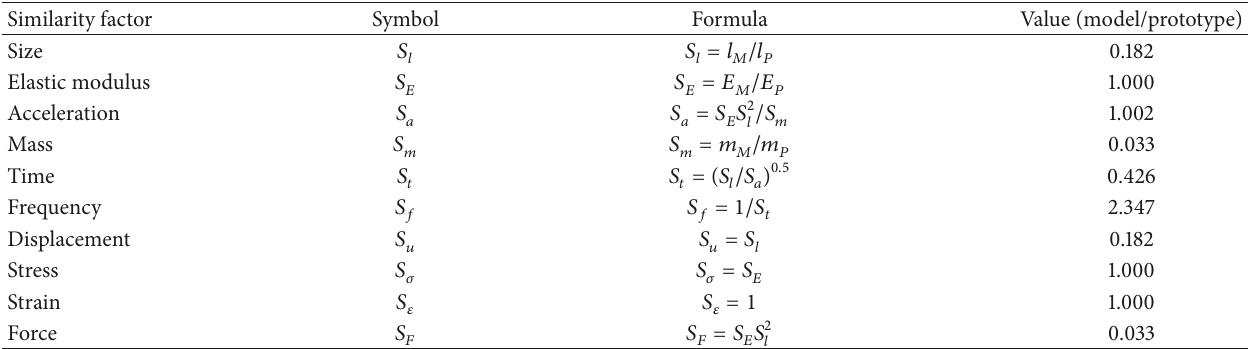
Table 7: Similarity relation between model and